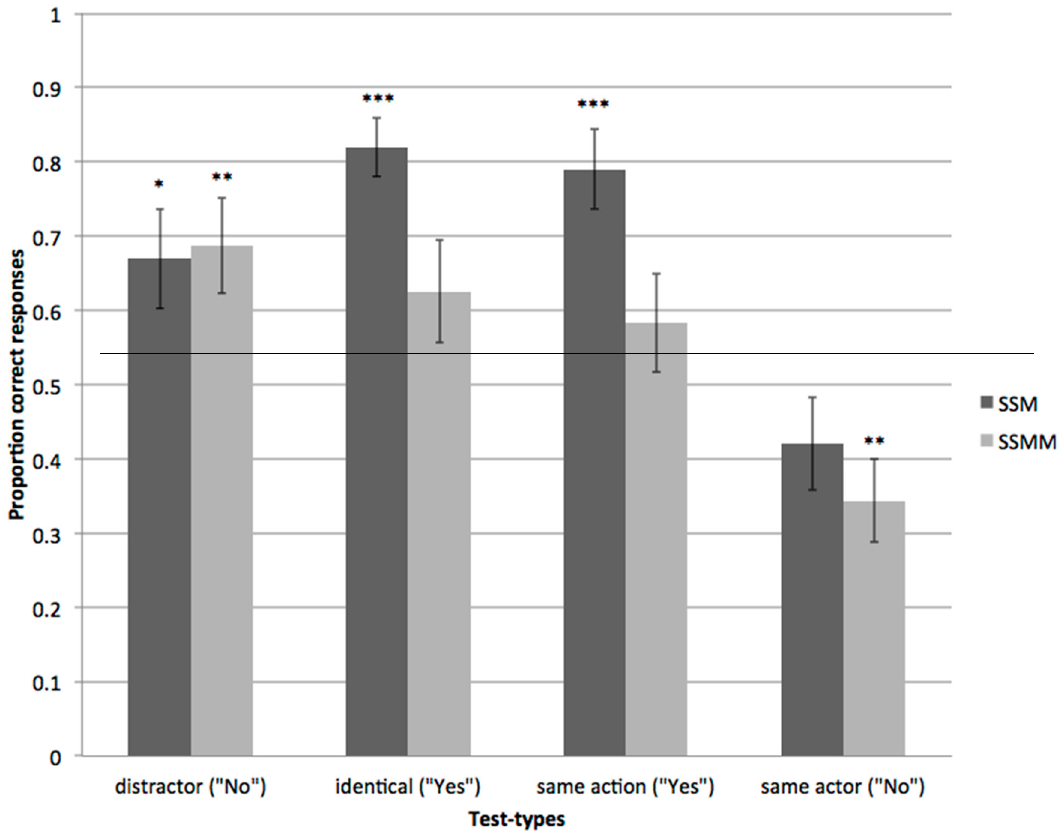
Figure 2. The proportion of correct responses in the sound-symbolically matching (SSM) and sound-symbolically mismatching (SSMM) conditions, in the four test-types: distractor, identical, same-action and same-actor. The correct response (“Yes” or “No”) is indicated in brackets. The error bars represent the standard error of the means. Whether or not the mean was significantly different to chance (0.5) is indicated by *** p < 0.001, ** p < 0.01 and * p < 0.05.